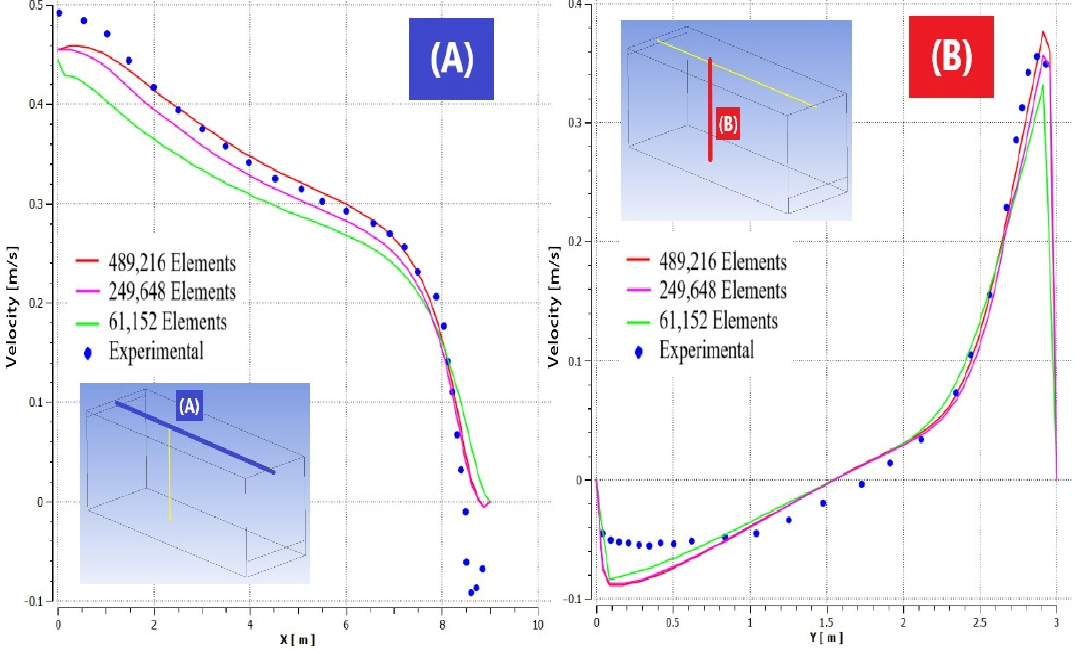
Figure 6. Horizontal ( A ) and vertical ( B ) grid independence analysis.